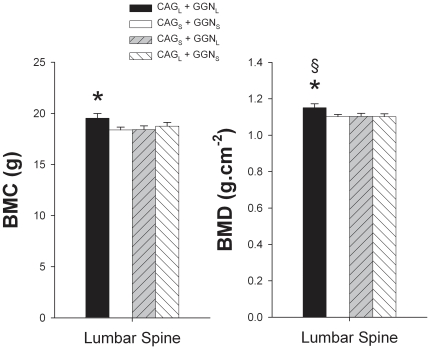
Mean lumbar spine (from L2, L3 and L4) bone mineral content (BMC) and bone mineral areal density (BMD).Subjects were grouped as CAG short (CAGS) if harboring repeat lengths of ≤21 and CAG long (CAGL) if harboring repeat lengths of >21. The cutoff point for GGN short (GGNS) was GGN repeat polymorphism ≤23, otherwise subjects were included in the GGN long (GGNL) group. Four haplotypes combinations were defined as: CAGL + GGNL, CAGS + GGNS, CAGS + GGNL, and CAGL + GGNS. * P<0.05 compared to CAGS + GGNS; § P<0.05 compared to CAGL + GGNS